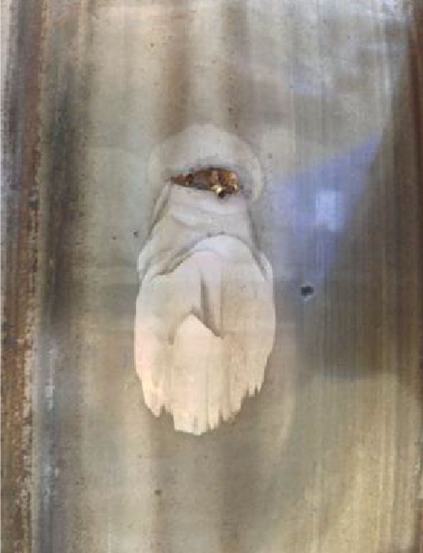
Fig. 1 Wheel tread with extensive cracking and spalling close to the field side